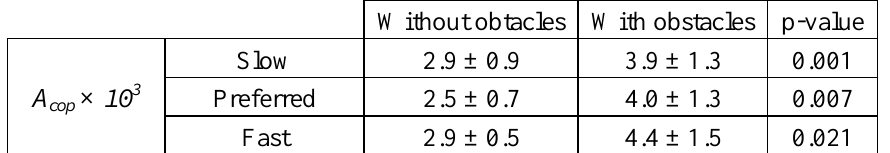
Table 2. The four parameters (mean ± SD) for the three walking speeds (slow, preferred and fast) at two sets of walking trials: without obtacles and with obstacles with corresponding p-values. Calculated evaluation parameters including CoP distribution area ( A the average coefficient of variation ( ACV ) of three directional forces in the two sets of walking trials implemented on seven subjects. ACV X , ACV Y and ACV Z are three directional components of ACV . Statistical significance was set at p < 0.05.